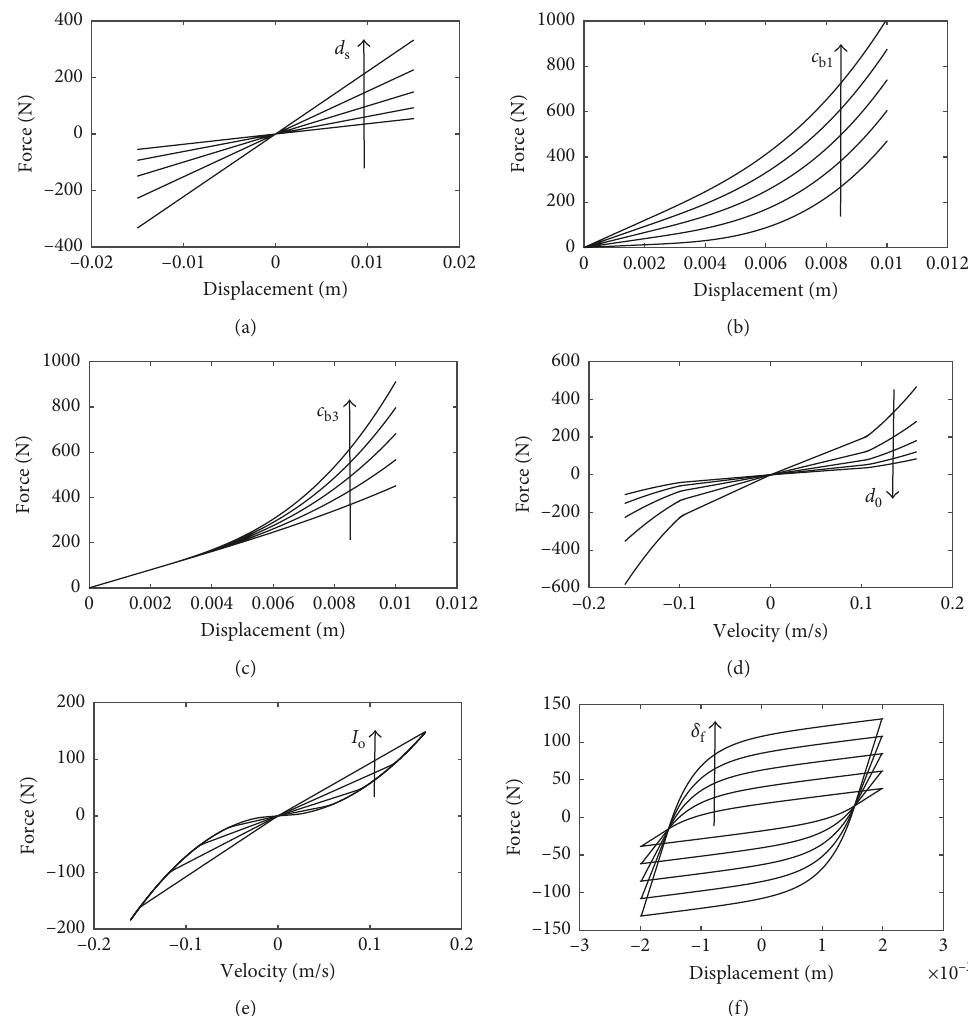
Figure 5: Force characteristics F different linear stiffness coefficient c force characteristics F different orifice length l